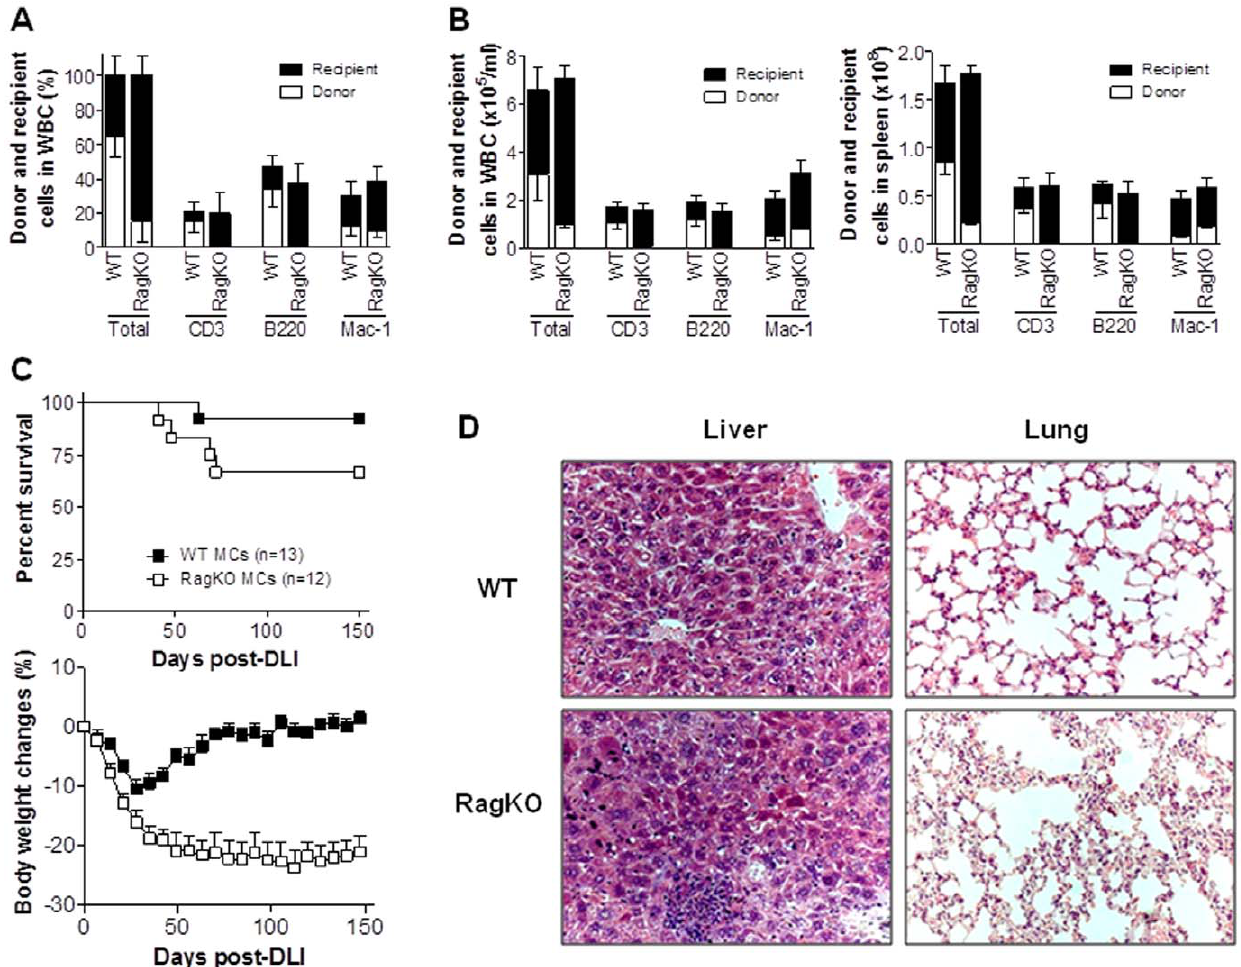
Figure 1. Donor BM-derived lymphocytes attenuate GVHD in mixed chimeras after delayed DLI. Lethally (8 Gy) irradiated BALB/c mice were reconstituted with a mixture of TCD BALB/c plus WT (WT MCs) or RagKO (RagKO BMCs) B6 BMCs 8 weeks before DLI (i.e., injection of 1.5 6 10 7 splenocytes) from allogeneic B6 donors. (A). Levels (%) of hematopoietic chimerism in peripheral blood measured 1 week prior to DLI. Data combined from four independent experiments are combined (WT, n=52; KO n=47). (B). Absolute donor and recipient cell counts in WBCs (left) and spleen (right) from WT and RagKO at week 1 post-HCT (n=3 per group). (C). Survivals (top) and body weight changes (bottom) of WT and RagKO MCs. Combined results from 2 independent experiments are shown. (D). Histological analysis (H&E; 6 200) of liver and lung tissues from representative WT and RagKO MCs at 150 days after DLI (D).